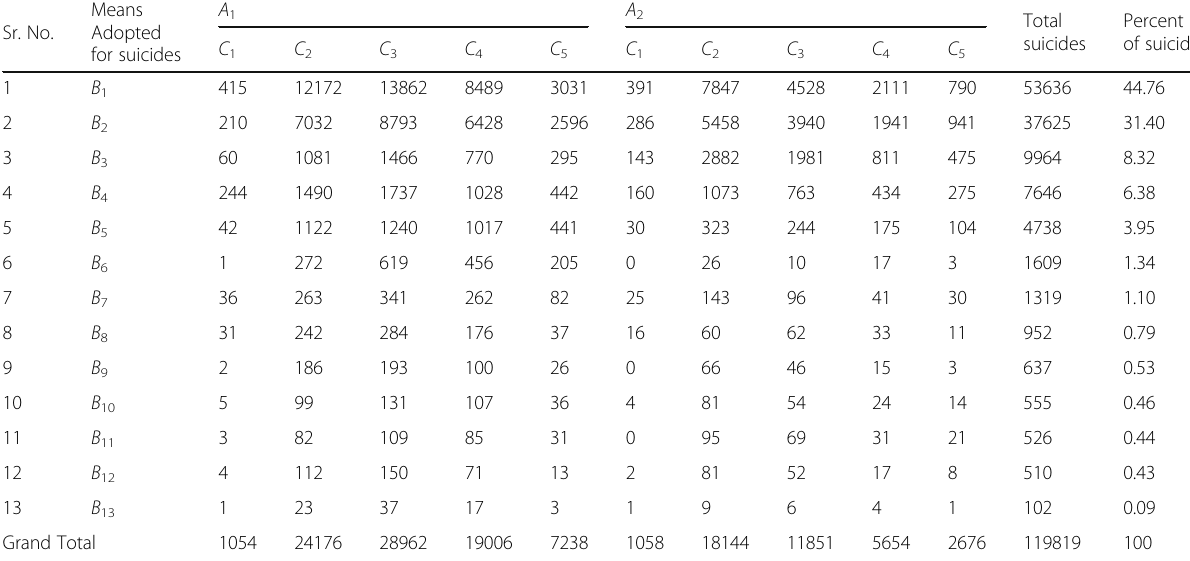
Table 6 Distribution of suicides by means adopted and gender across age group in 2013 Sr. No.